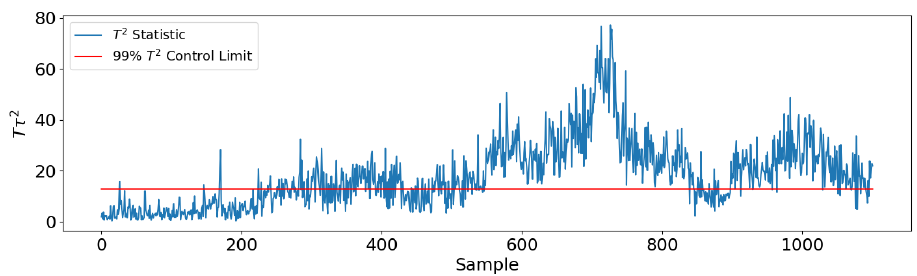
Figure 14. Monitoring results of industrial case based on cointegration analysis.